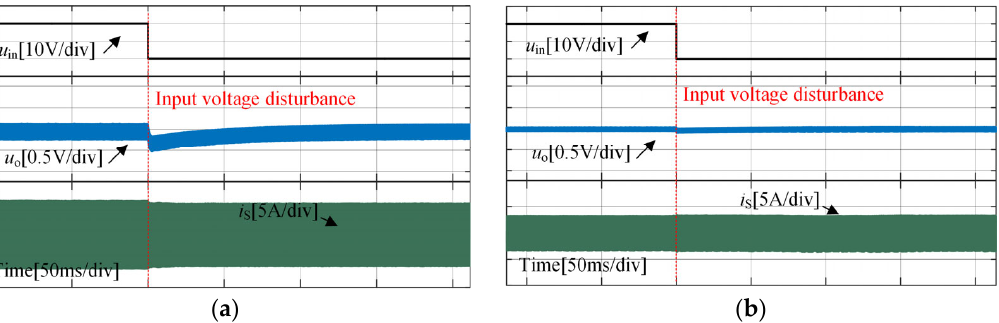
Figure 14. Transient response waveforms with two control methods when input voltage changed from 100 to 80 V. ( a ) SPS modulation; ( b ) Soft ‐ switching and no backflow power control.